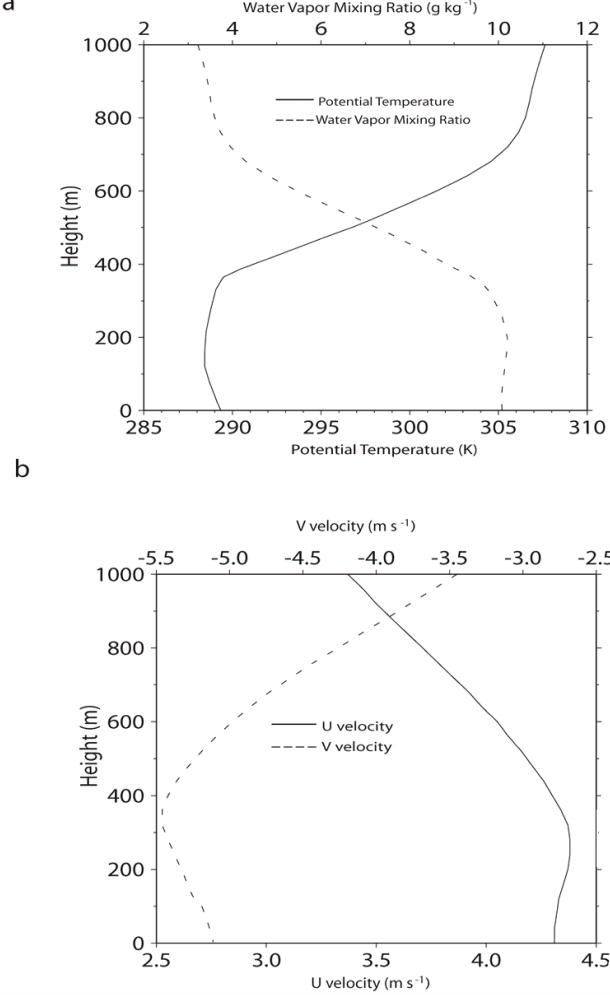
Fig. 1. Vertical profiles of (a) initial potential temperature and water vapor mixing ratio and (b) initial horizontal wind ( u,v ) velocity for the CSRM